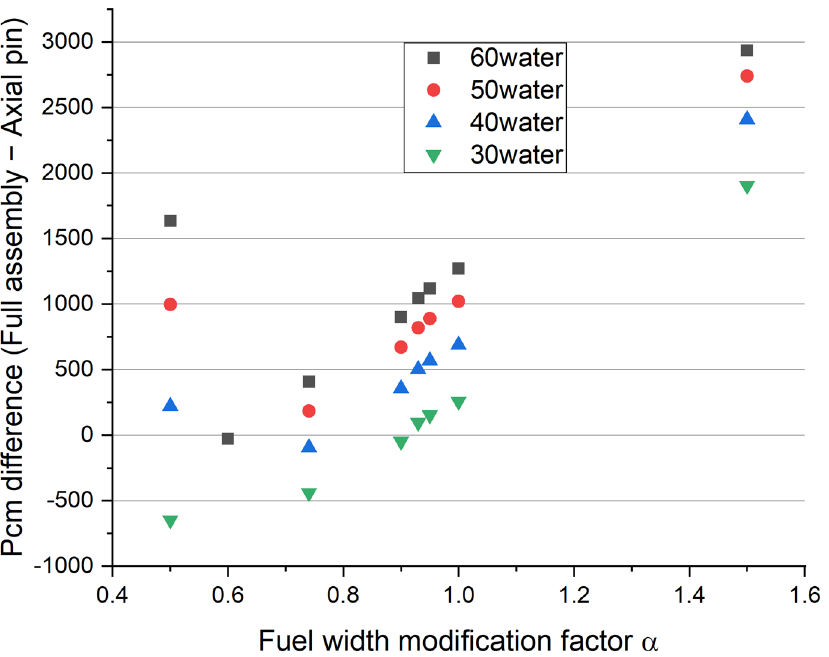
Figure 15. Difference in pcm units between the k-eff values of the full assembly radial model and an Figure 15. Di ff erence in pcm units between the k-e ff values of the full assembly radial model and an equivalent axial pin model modified by the given fuel width modification factor. Different factors for equivalent axial pin model modi fi ed by the given fuel width modi fi cation factor. Di ff erent factors for modi fi cation are required to minimise the di ff erence in behaviour between the two models, with modification are required to minimise the difference in behaviour between the two models, with the the largest modi fi cation required for the lowest void fraction, as expected. largest modification required for the lowest void fraction, as expected.